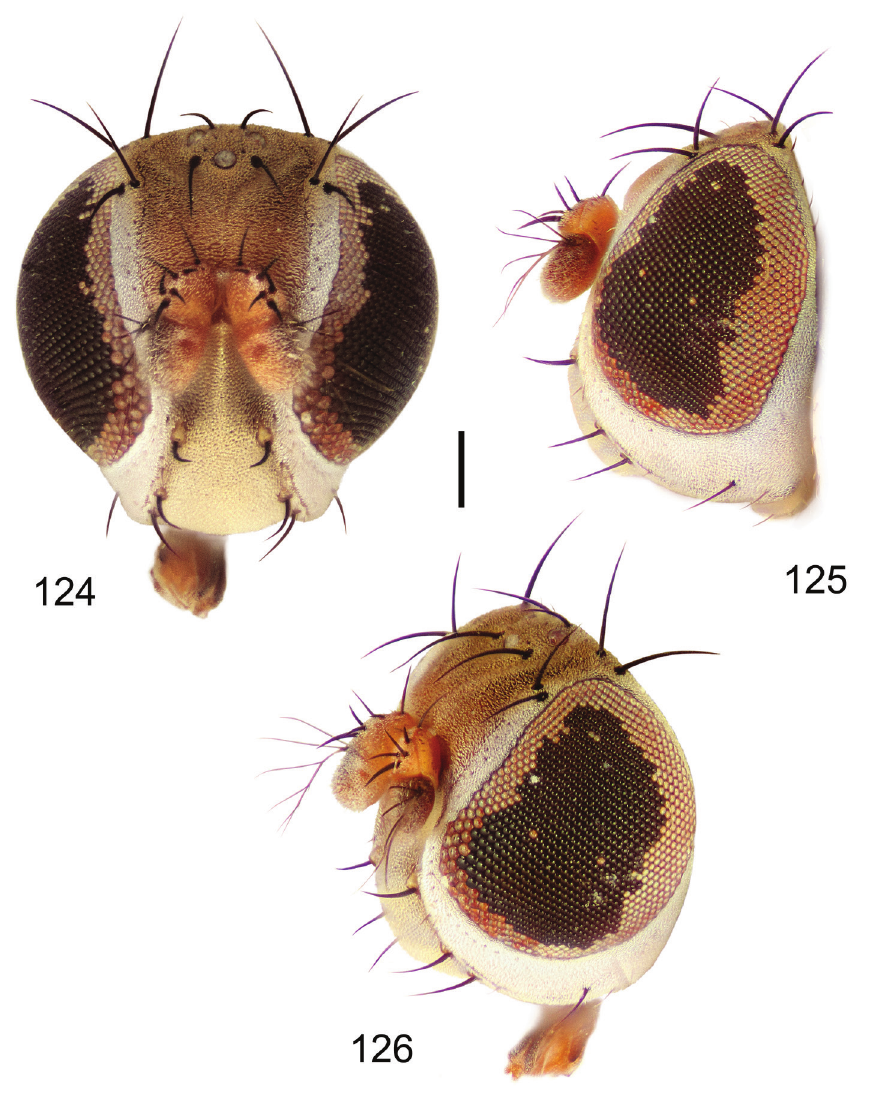
Figures 124–126. Hydrochasma urnulum sp. n. (Dominican Republic. LaVega: Jarabacoa) 124 head, anterior view 125 same, lateral view 126 same, oblique view. Scale bar = 0.1